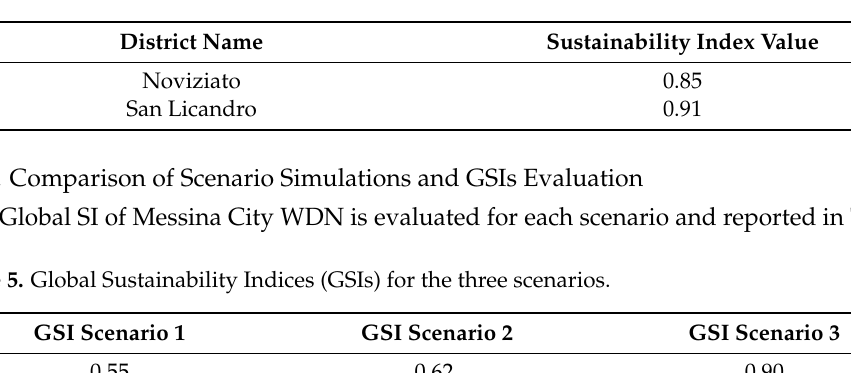
Table 4. SI values for the district with PRV in Scenario 3.